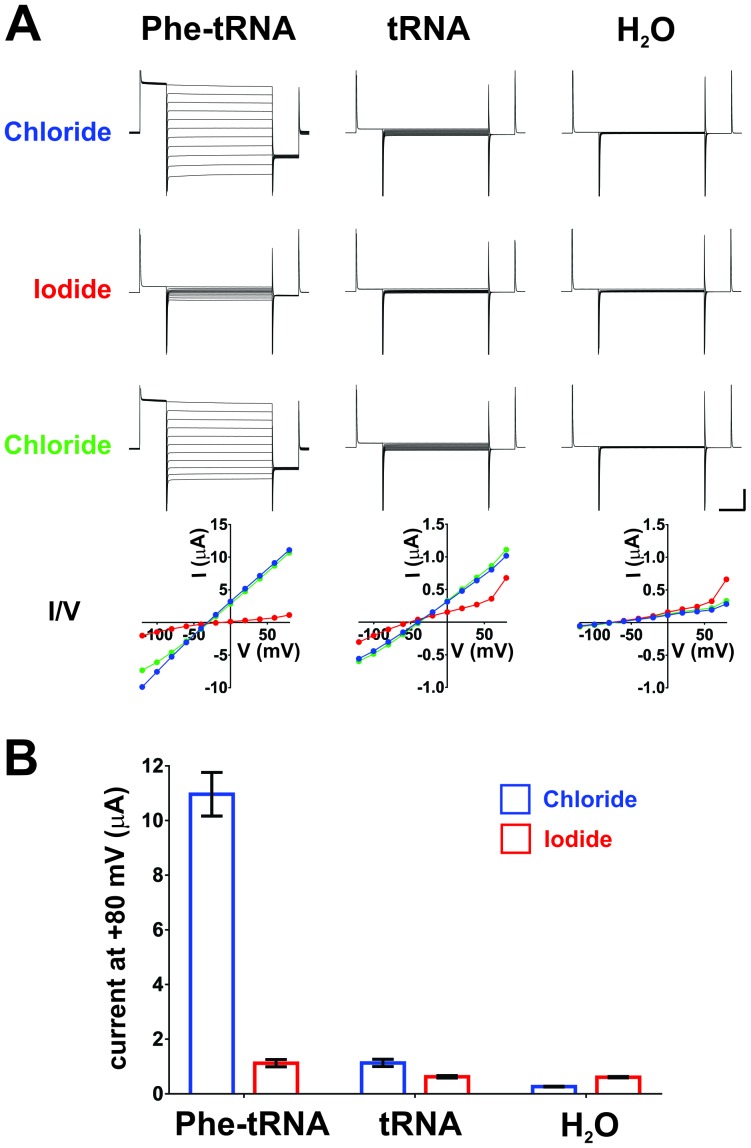
Iodide blocks ClC-0 E166Phe currents, indicating that they are indeed ClC-0 mediated.(A) Oocytes injected with ClC-0 E166TAG cRNA and Phe-tRNA (left) or ClC-0 E166TAG cRNA and non-acylated tRNA (center) or with water (H2O, right) were perfused with the following sequence of ions: Chloride (blue), Iodide (red), Chloride (green). Representative current traces for each condition and the corresponding current-voltage (I/V) relationships are shown (vertical scale bar: current, 5 µA; horizontal scale bar: time, 50 ms). In Cl--containing saline reversal potentials were estimated to be ~−30 mV for Phe-tRNA (left), ~−40 mV for tRNA and ~−65 mV for H2O (right) injected oocytes. (B) Averaged currents evoked by a +80 mV pulse in Chloride and Iodide, respectively, are shown as mean ± s.e.m. for each condition (n = 7 for Phe-tRNA, n = 5 for tRNA, n = 5 for H2O; from 2–3 different batches of oocytes).